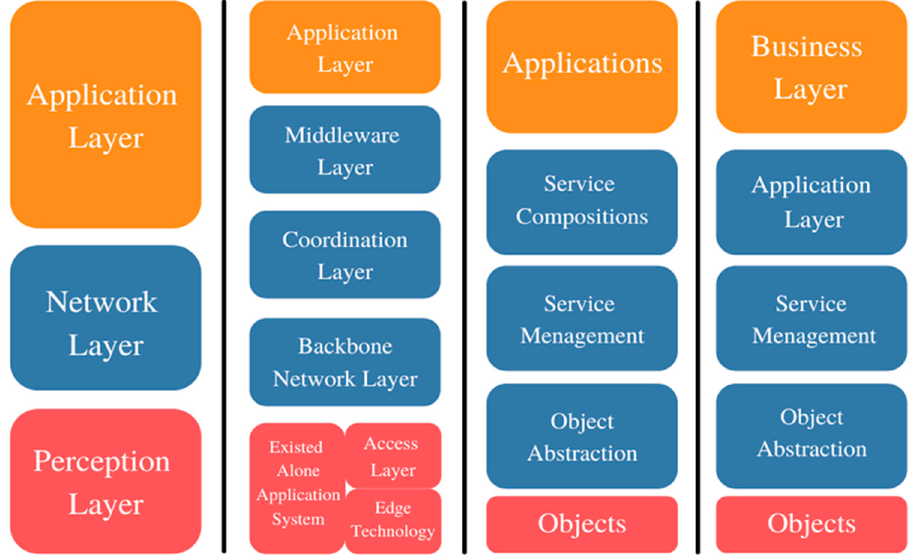
Figure 8. Proposed models of IoT architecture layers. The three-layer architecture on the left can be divided into sublayers. The most recent architectural designs propose five layers.